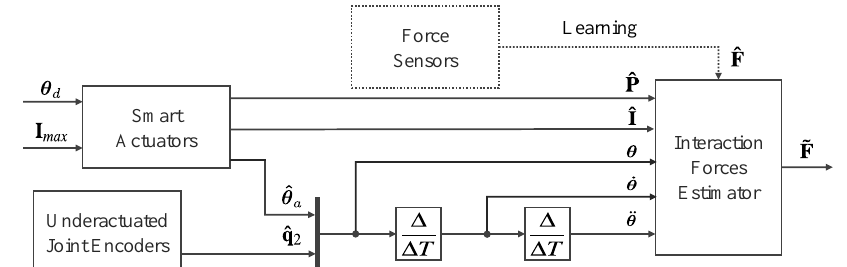
Figure 3. Representative schematic of the intelligent perception system. The regression model uses the measurements from the proprioceptive sensors of the smart actuators and the underactuated joints to estimate external forces. The dotted line represents the supervised learning process, which uses ground-truth forces measured with force sensors for